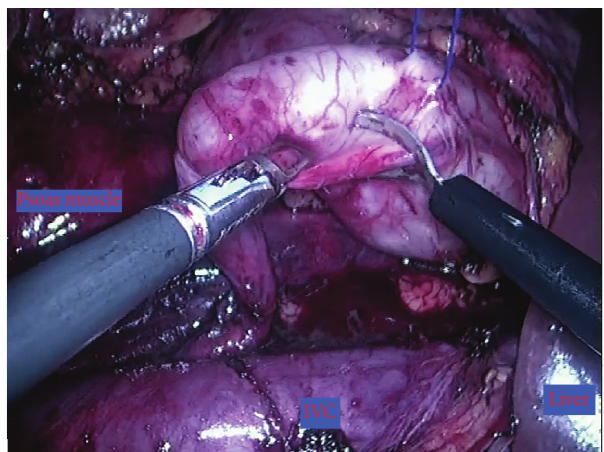
Figure 4: Preparing for pyeloplasty after suspension of the renal pelvis.